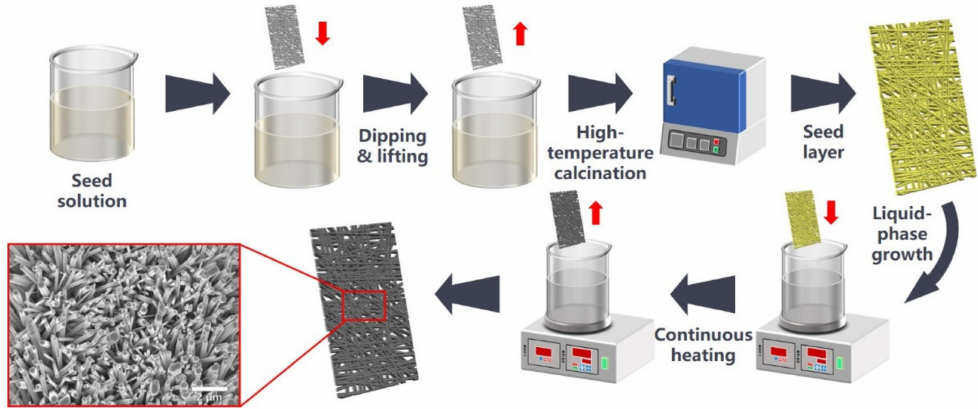
Figure 1. Schematic illustration of manufacturing ZnO modified metal fiber